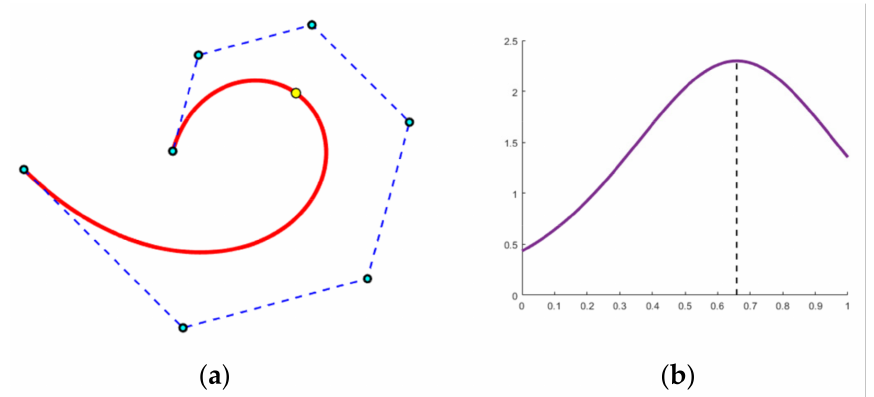
Figure 13. Typical B é zier curve with degree k = 6 for s > cos θ (0 < s < 1). ( a ) Transformation matrix M = 0.85 · ; point with curvature extremum is represented by yellow dot; ( b ) curvature plot has a maximum at t ∗ = 0.6590.